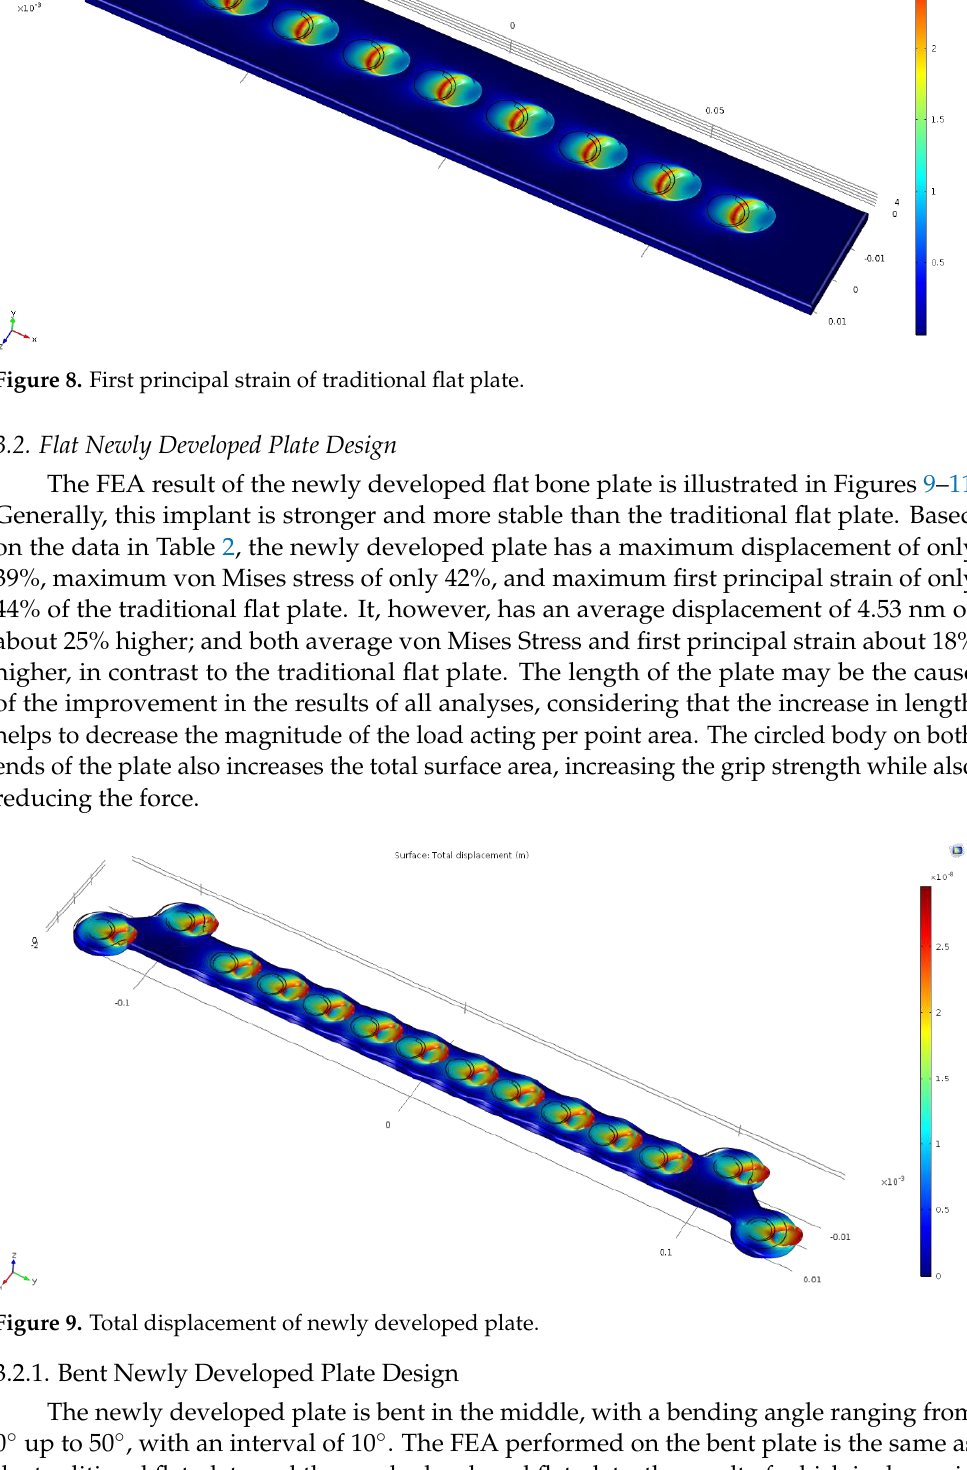
Figure 7. Von Mises stress of traditional flat plate.